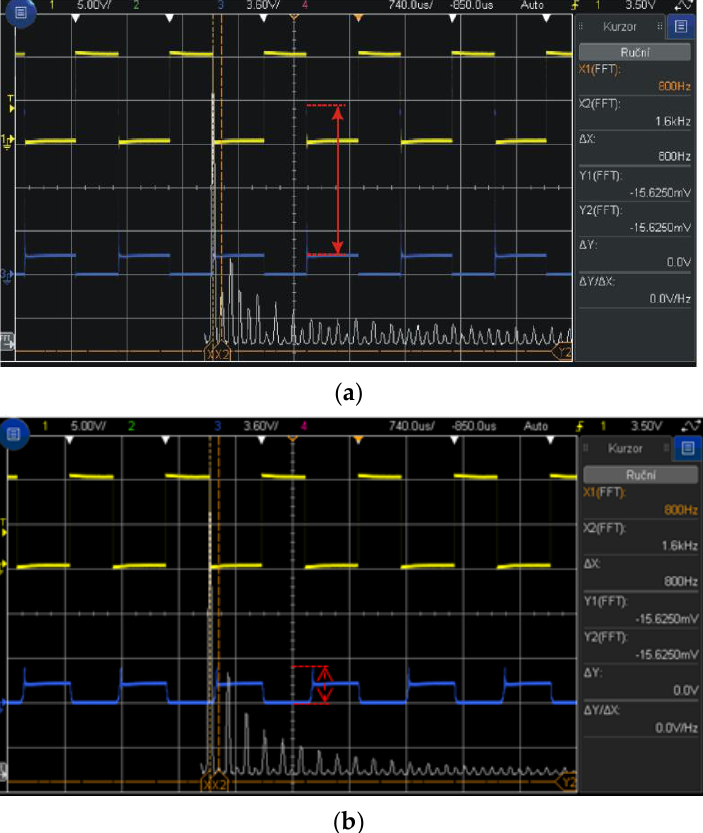
Figure 17. Rising edge as the source of electromagnetic interference. ( a ) High level of interference caused by fast switching; ( b ) interference with normal